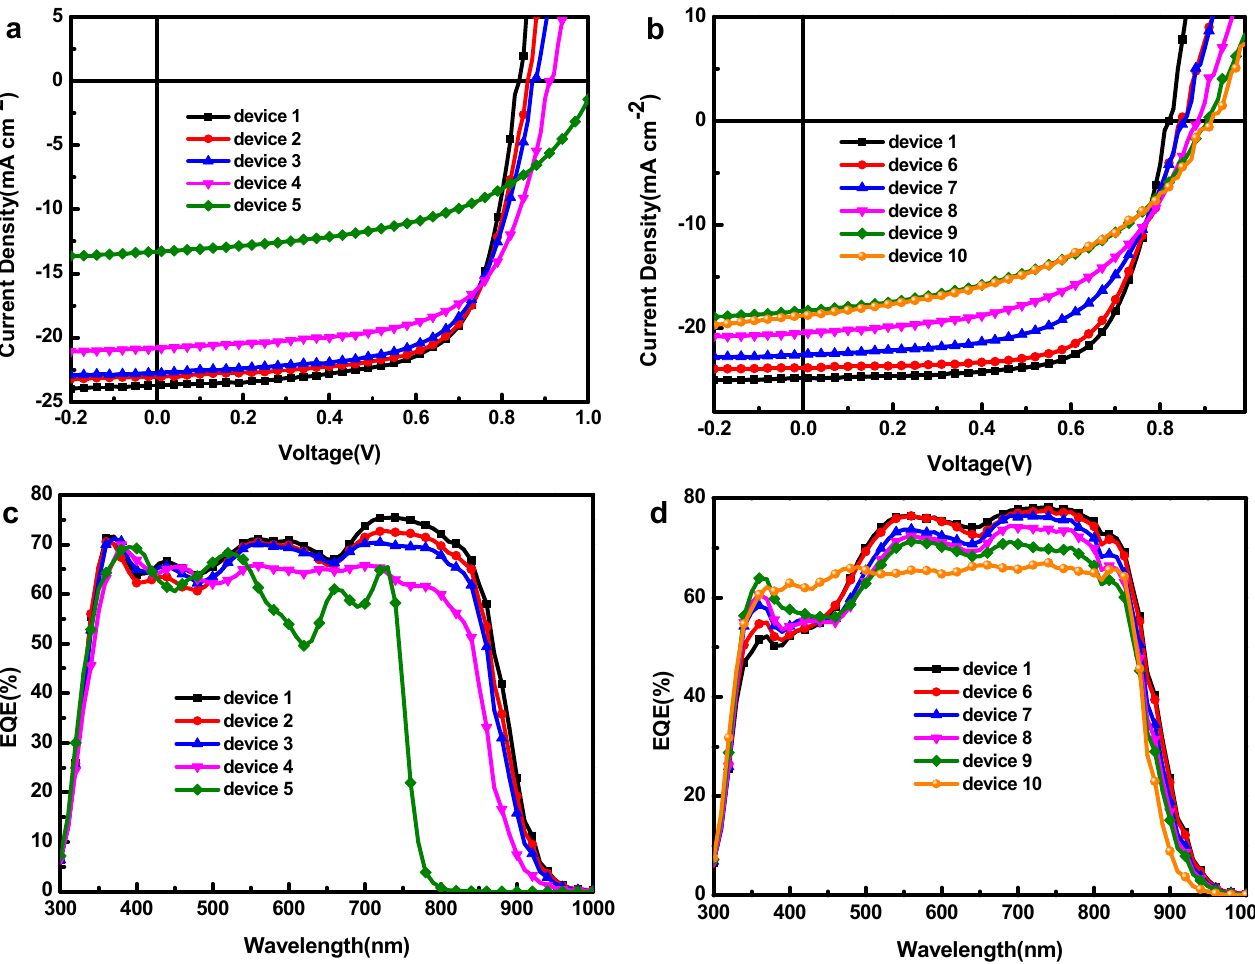
Figure 3. J - V characteristics of ( a ) devices 1 to 5, ( b ) devices 1, 6 to 10, EQE curves of ( c ) device 1 to 5, ( d ) device 1, 6 to 10. (R sh ) and series (R s ) resistances of these devices are from their J-V curves.